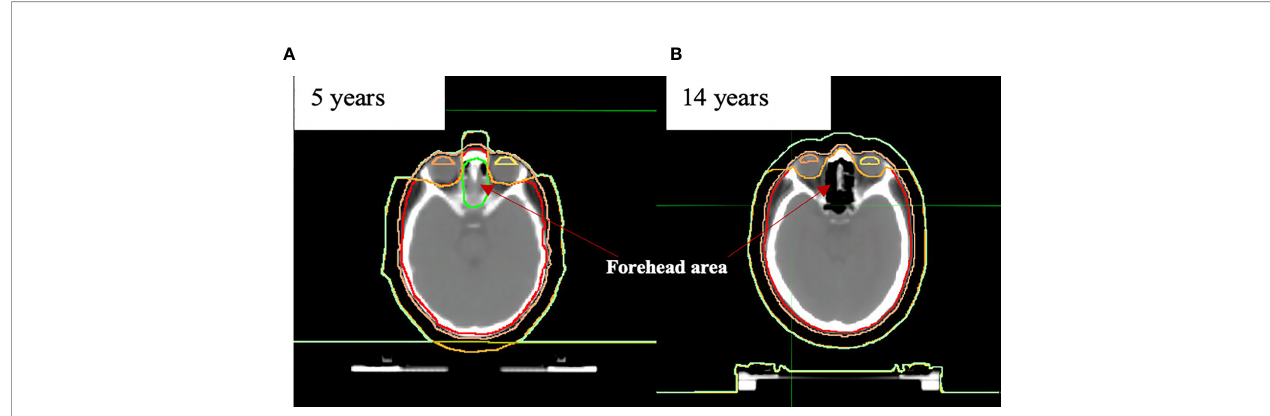
FIGURE 2 | Anatomical differences in “ forehead area ” in the example of (A) 5- and (B) 14-year-old